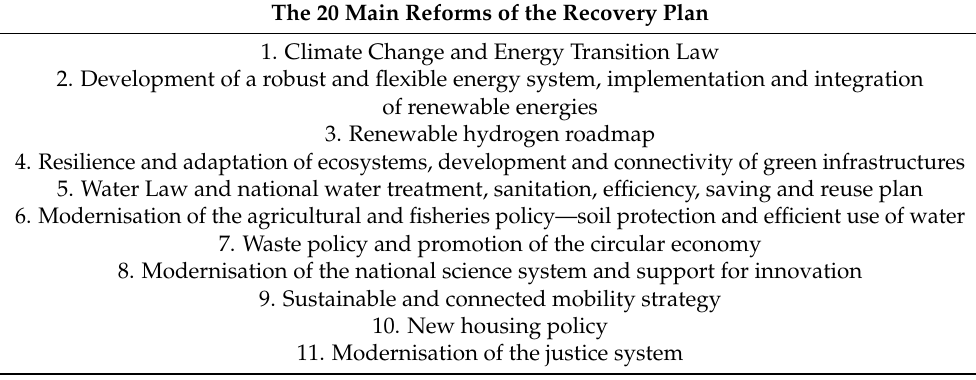
Table 4. Main reforms of the Recovery Plan. Source: own elaboration based on data from the Spanish Recovery Plan